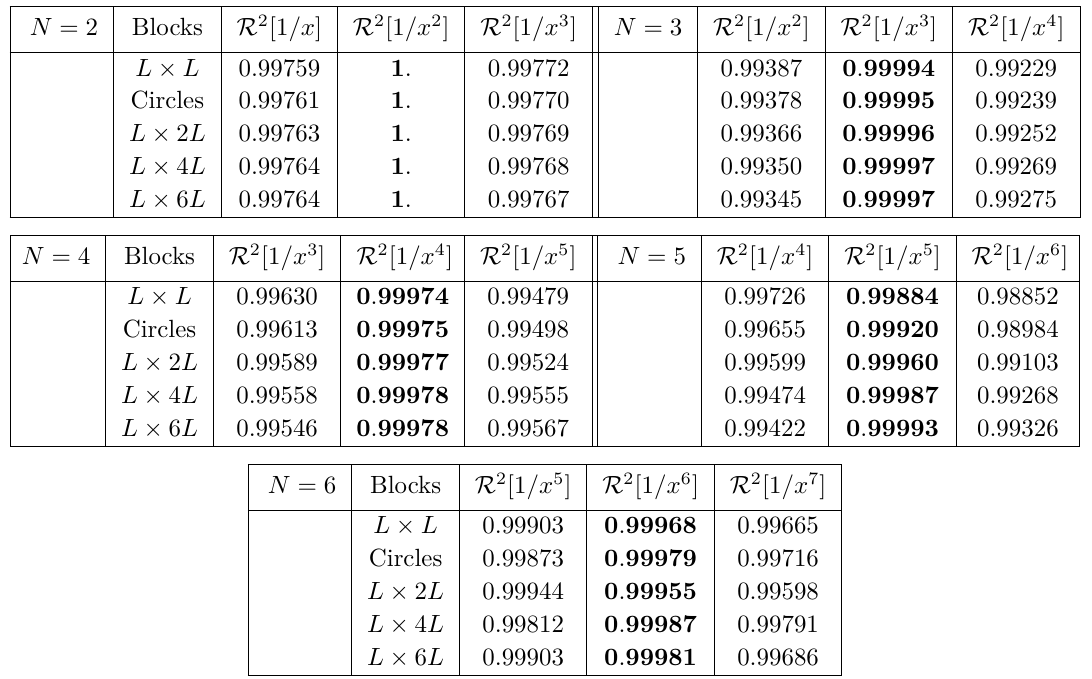
Table 2 . We show the values of the coefficient of determination, R 2 , of different fits to the long-distance results obtained for I N , with N = 2 , 3 , 4 , 5 , 6 , for a free scalar field in the lattice. In each case, we consider sets of N identical entangling regions (squares, disks and increasingly thinner rectangles) placed on a regular N -gon arrangement. R 2 is computed for fits of the form I N ∼ (1 /x ) α with α = N − 1 , N, N + 1